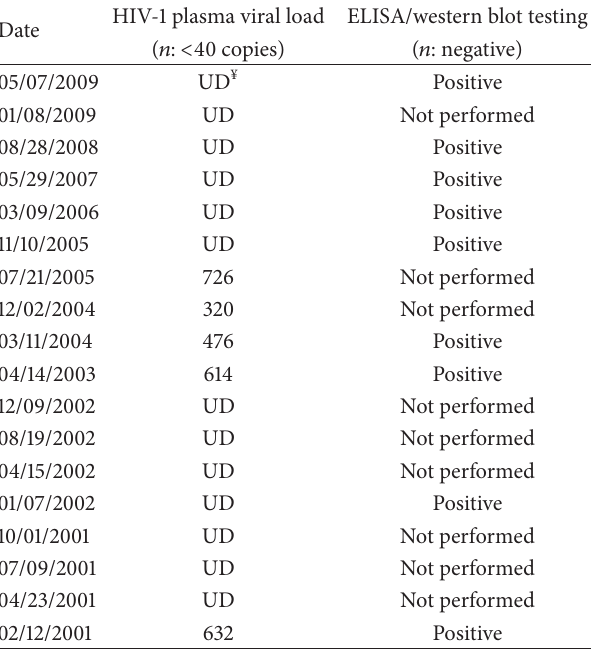
Table 2: Clinical laboratory results: HIV viral